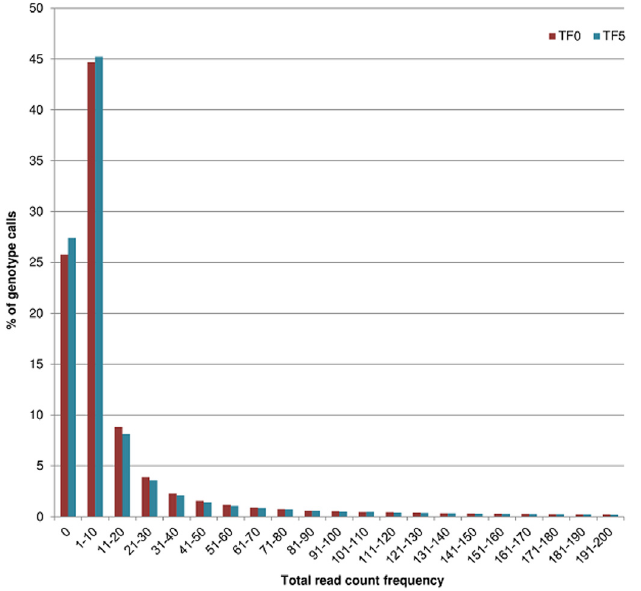
Fig 1. Observed frequency distribution of total read counts (A1+A2) supporting each genotype call in ATF0 and ATF5 populations. Genotype calls (5%) supported by > 200 reads are not shown.